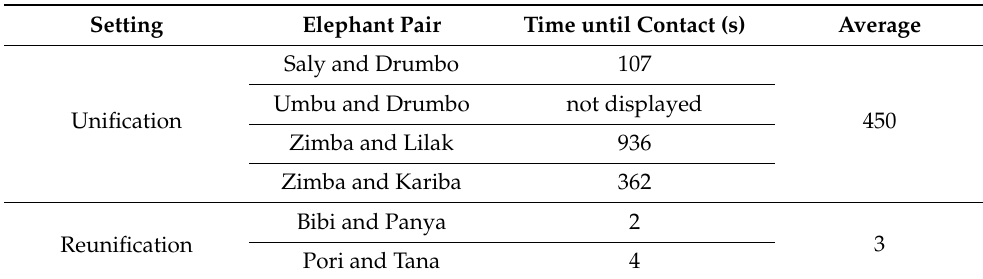
Table 6. Significances for distance to the fence between related and unrelated elephants during (re)unification. Table 7. Seconds until first contact of trunks during (re)unifications for the different pairs that were